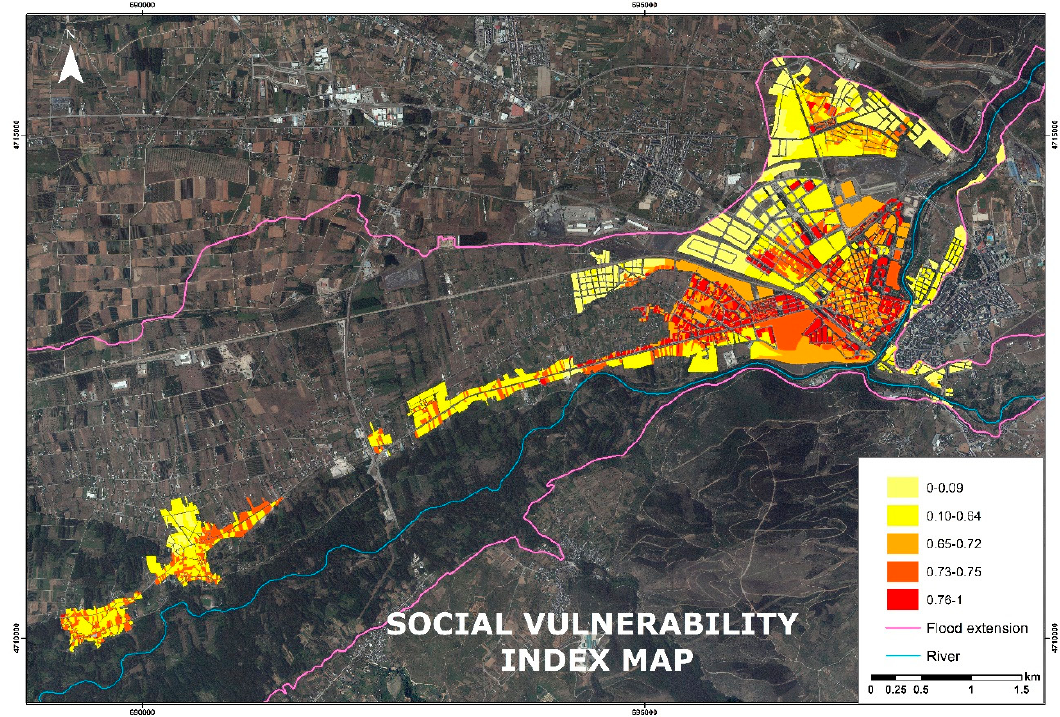
Figure 4. Map of the social vulnerability in Ponferrada due to a potential dam break. Break values of the legend correspond to the quantile distribution to better visualize the spatial distribution of index values.